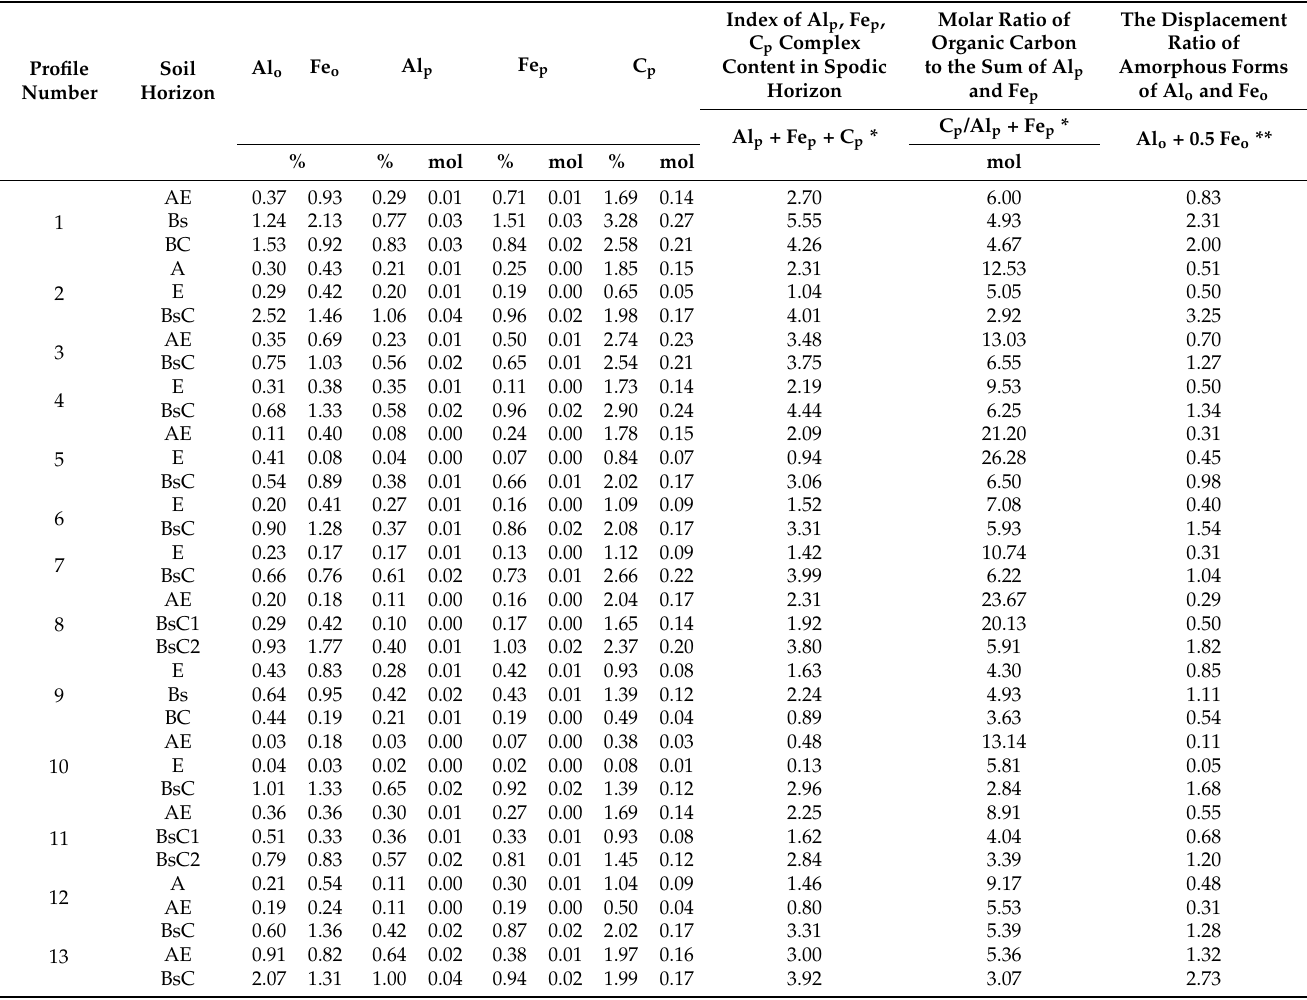
Table 3. Content of different forms of iron and aluminum and the values of indicators for spodic horizon in eluvial and illuvial soil